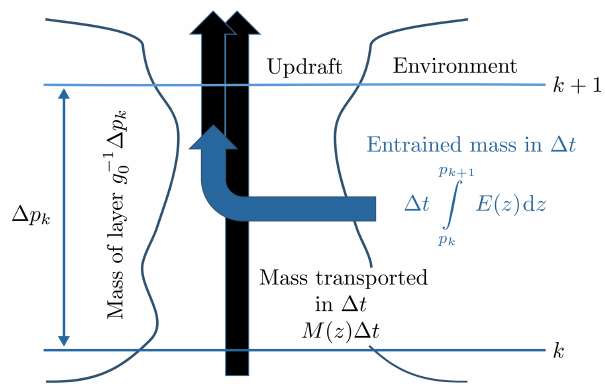
Figure 1. Schematic representation of the entrainment step. All quantities are per unit